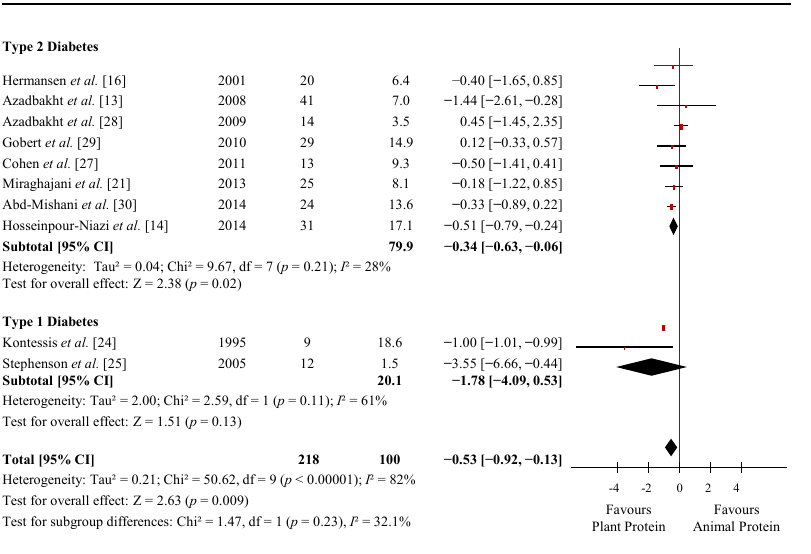
Figure 3. Forest plot of randomized controlled trials investigating the effect of replacing sources of animal with plant protein in individuals with diabetes on fasting glucose. Pooled effect estimates for each subgroup and overall effect are represented by the diamonds. Data are expressed as weighted mean differences with 95% confidence intervals (CIs), using the generic inverse-variance method with random effects models. Paired analyses were applied to all crossover trials. Inter-study heterogeneity was tested by the Cochran Q-statistic and quantified by I 2 at a significance level of p < 0.10; d f , degrees of freedom.